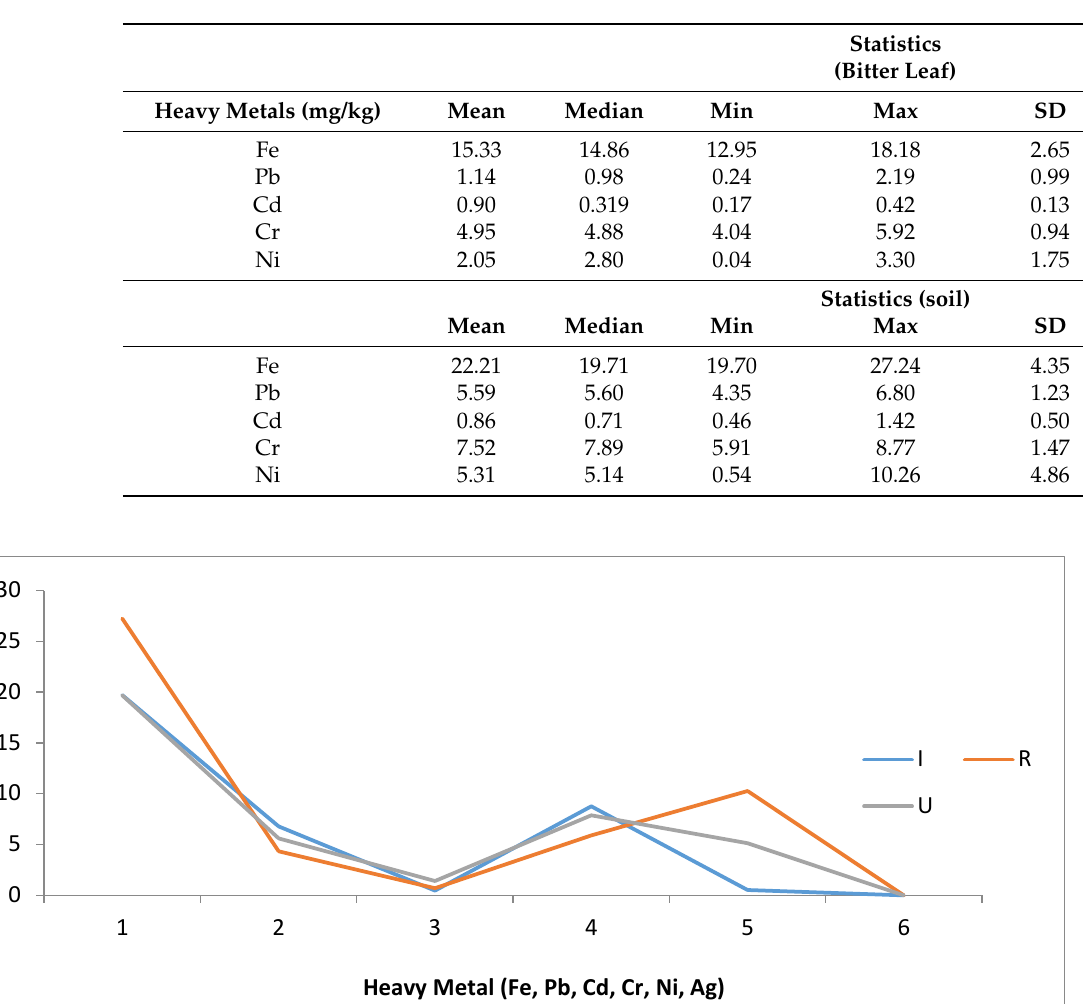
Table 12. Statistics of Fe, Pb, Cd, Cr, and Ni in both Vernonia Amygdalina Delile and soils in the study stations.